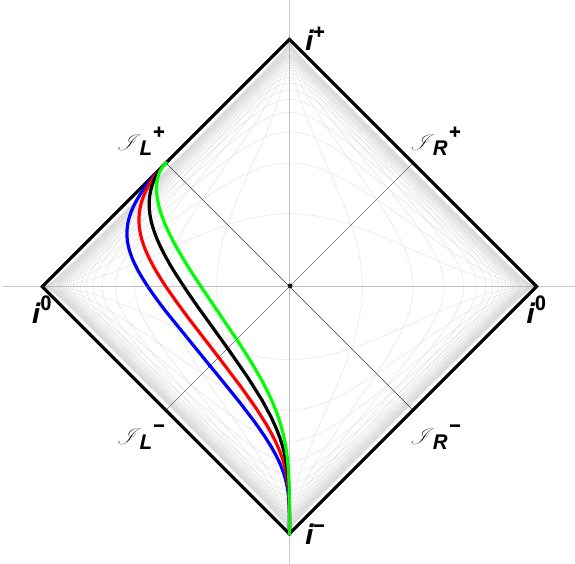
Figure 1. A spacetime diagram of the mirror trajectory, Equation (5). It starts off asymptotically static at x = 0 with zero acceleration and zero velocity and accelerates to the left eventually reaching the speed of light with a horizon at t = − x , or v H = 0, evolving to asymptotically inertial motion as v → 0 − . Notice how field modes moving to the left at times greater than v > 0 will never hit the mirror, demonstrating a bona-fide horizon. One cannot see any telltale signs from the spacetime graph that α → 0 as v → 0 − .